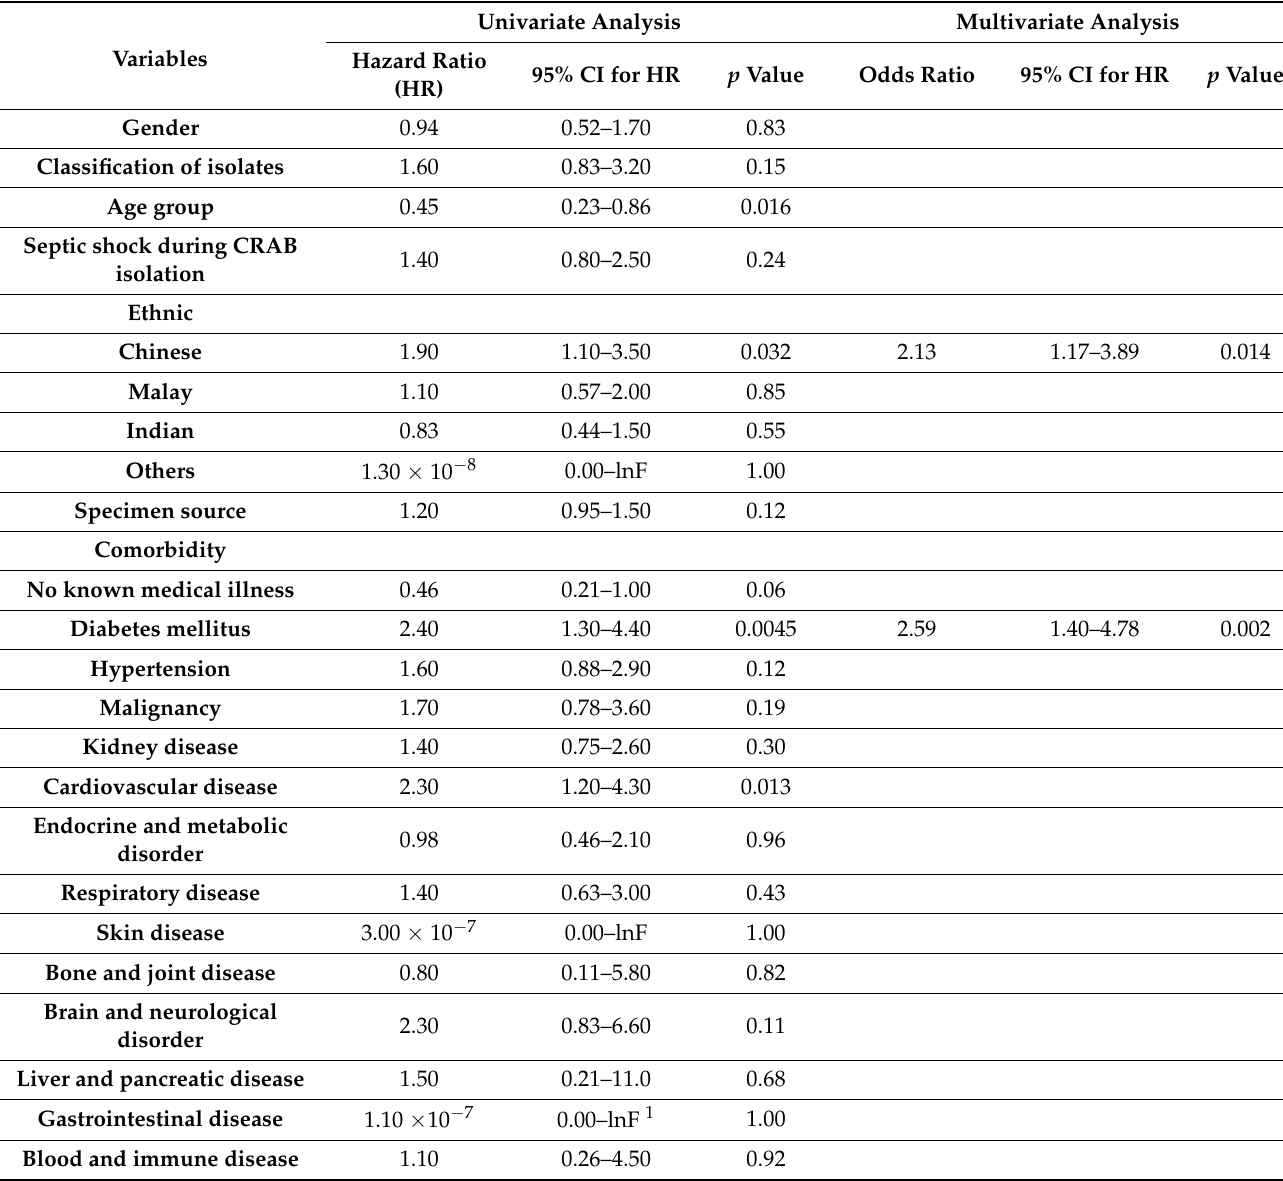
Table 2. Cox proportional hazard model for patients’ in-hospital all-cause mortality associated with carbapenem-resistant Acinetobacter baumannii ( n =